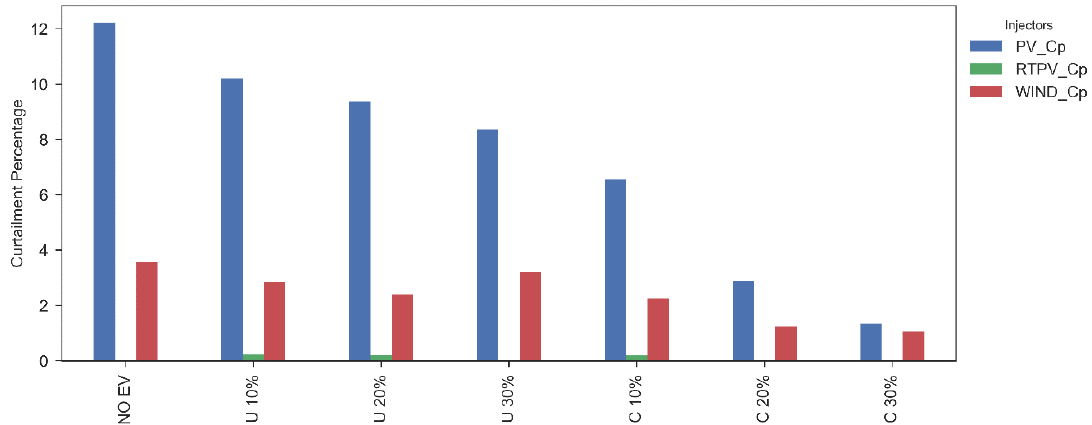
Figure 16. VRE curtailments during the Duck week in April for all scenarios and charging strategies.